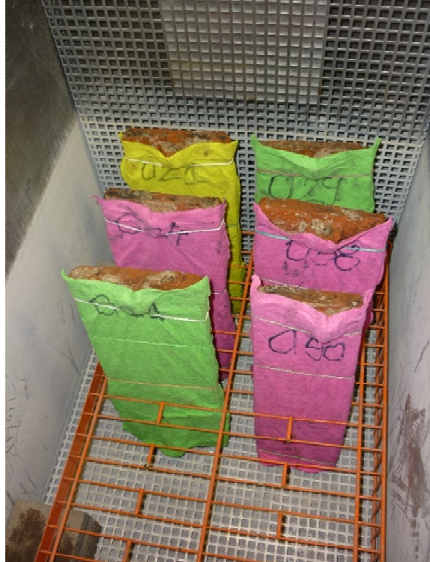
Figure 7. Roof tiles in a climate chamber. Table 1. Comparison of the visual condition of the selected tiles before and after the frost resistance test. Tile No.